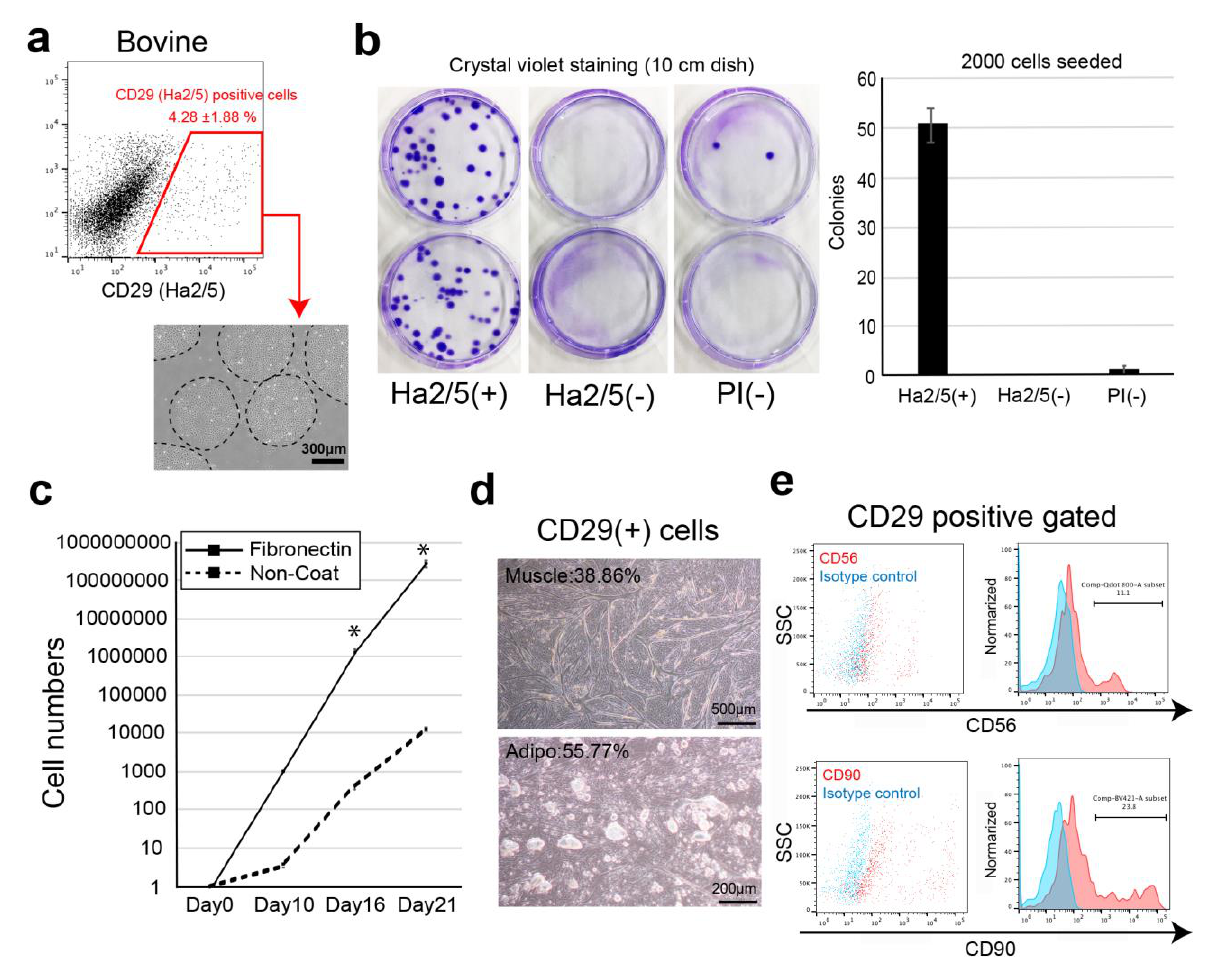
Figure 1. Isolation of colony-forming cells by cell surface markers. ( a ) Representative flow-cytometric profiles of bovine muscle tissue stained with CD29 (Ha2/5 clone) antibody. Phase-contrast micrographs of Ha2/5 positive cells. Scale bar = 300 µ m. ( b ) Analysis of colony-forming capacity of the Ha2/5+ fraction. Two thousand CD29+, CD29–, and all living cells were sorted and cultured in 10 cm dishes for 14 days. The cells were stained with crystal violet, and the colonies were counted. ( c ) CD29+ cells were cultured on fibronectin-coated (line) and non-coated (dot-line) culture dishes. The graph shows the cultured cell numbers during 21 days. Results are expressed as mean ± SE ( n = 3). * p < 0.05. ( d ) Differentiation capacity of CD29+ cells. Scale bar = 500 µ m. ( e ) The expression of CD56 and CD90 cell surface markers in CD29 positive fraction (red). Isotype control is used for negative samples